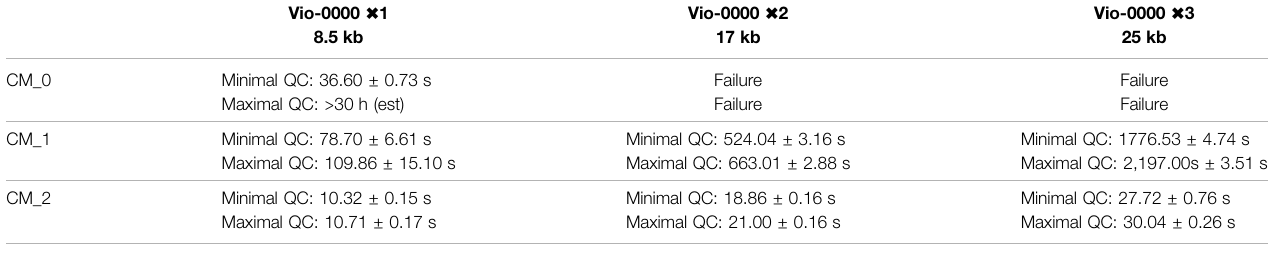
TABLE 3 | Comparative performance of the algorithms for constructs of increasing complexity and lengths. Performance was estimated for all three algorithms and in the minimal and maximal QC cases. The test constructs were generated by concatenating the test construct Vio-0000 a number of times.